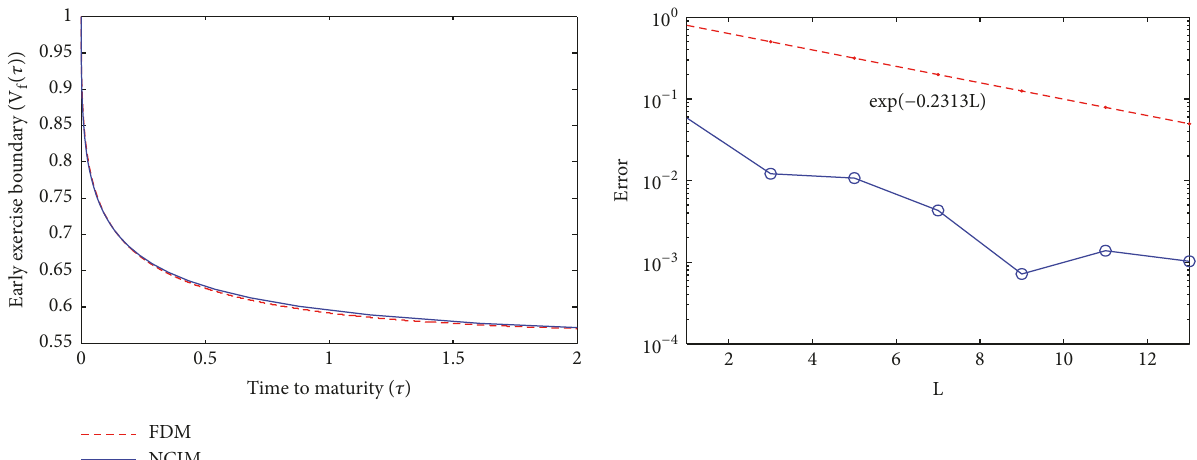
Figure 2: Early exercise boundaries (left) under GBMP model with 𝑇/2000 for FDM and 𝐿 = 14 for NCIM, NCIM errors in log-scale versus 𝐿 (right).